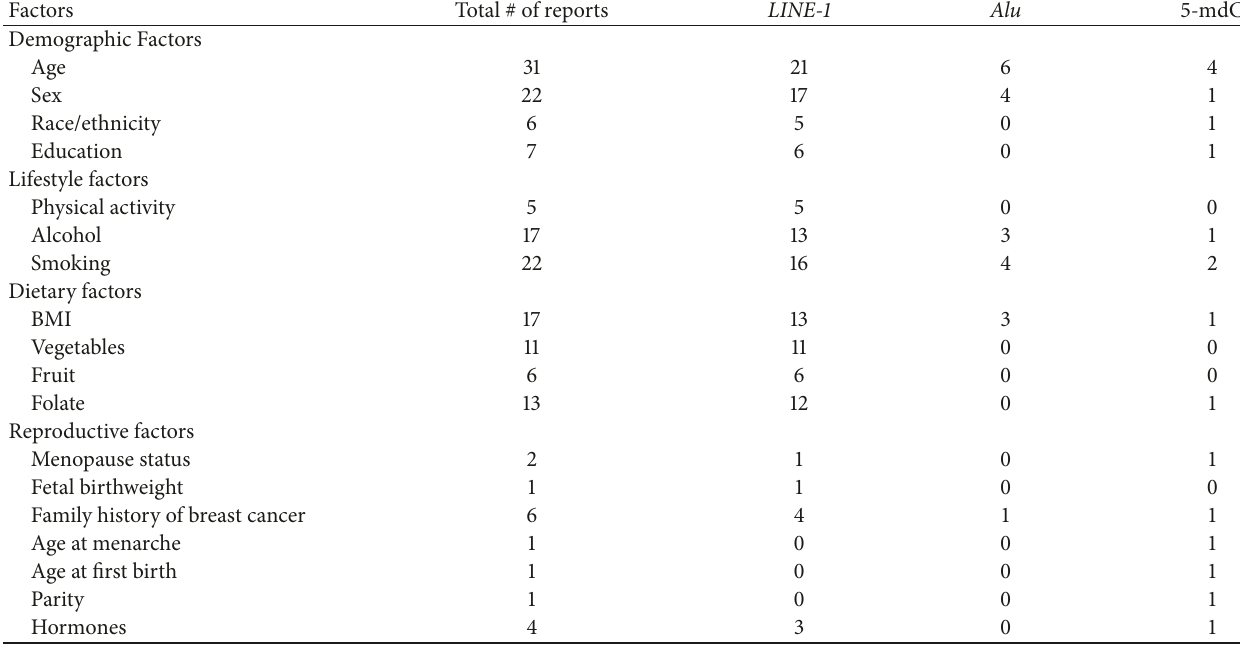
Table 1: Summary of number of reports by risk factor and global methylation